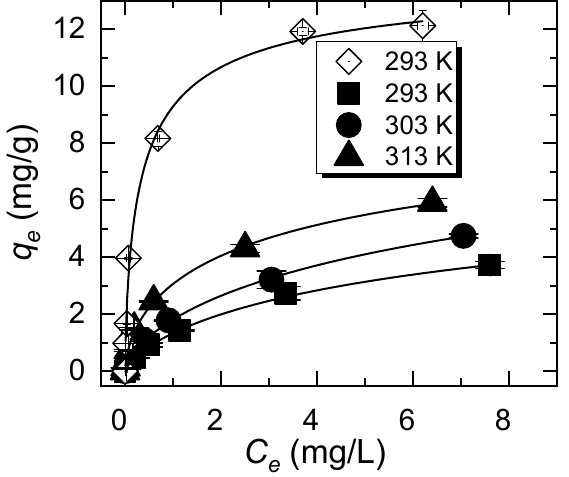
Figure 3. Adsorption isotherm of Co(II) for p-HdA (open symbol) and b-HdA (solid symbols) at various temperatures. Note that the lines show the best fits of the Sips model.